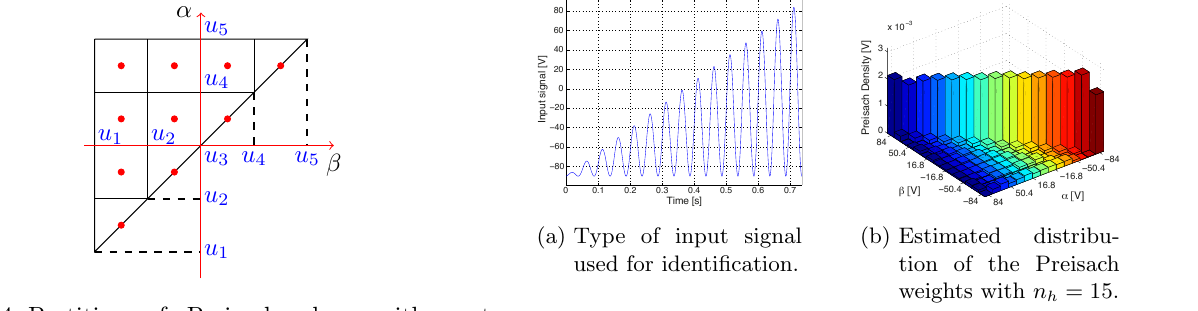
Figure 6: Fig. (a) shows an example of an input sig- nal with sufficient reversals for identification of a Prisach model with discretization level n h = 15. Fig. (b) shows the correspond- ing Preisach distribution based on the input signal in Fig.